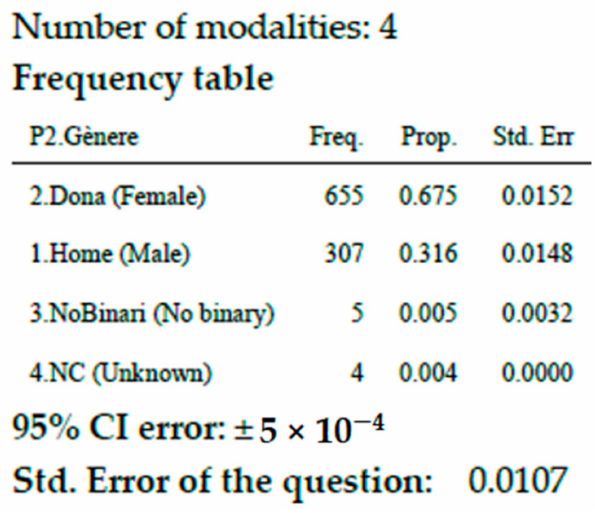
Figure 21. Frequency table of